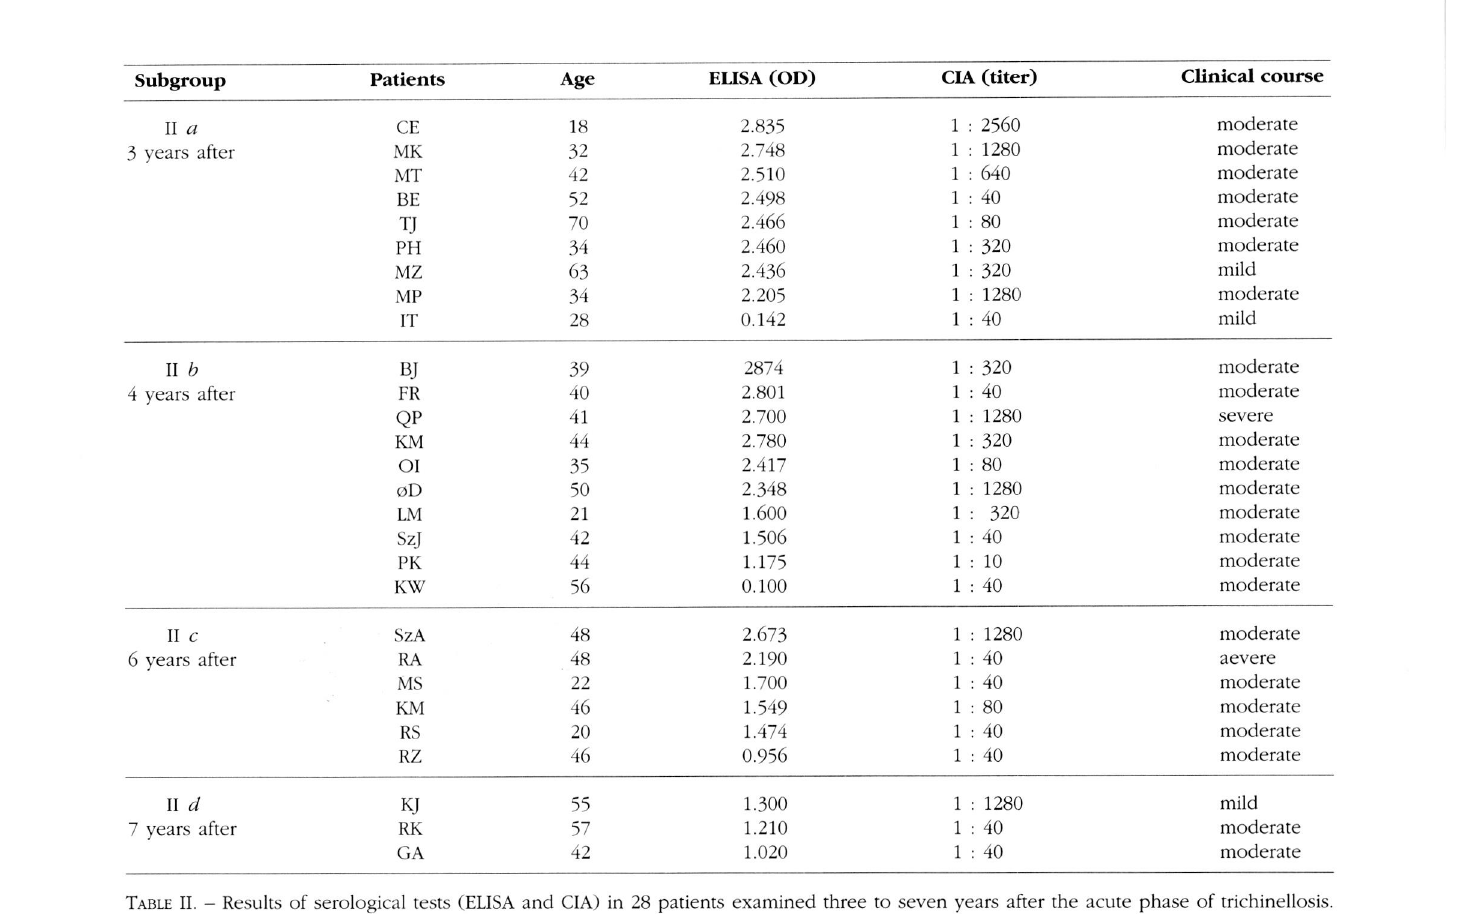
Table II. - Results of serological tests (ELISA and CIA) in 28 patients examined three to seven years after the acute phase of trichinellosis.